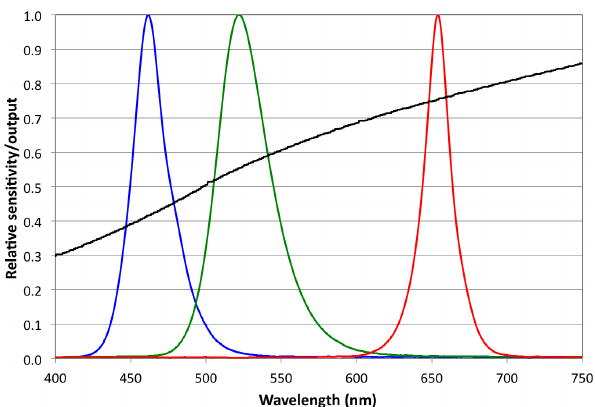
Figure 3. Normalized spectral output of the light source for the blue, green, and red channels, and spectral sensitivity of the detec- tors (black curve).